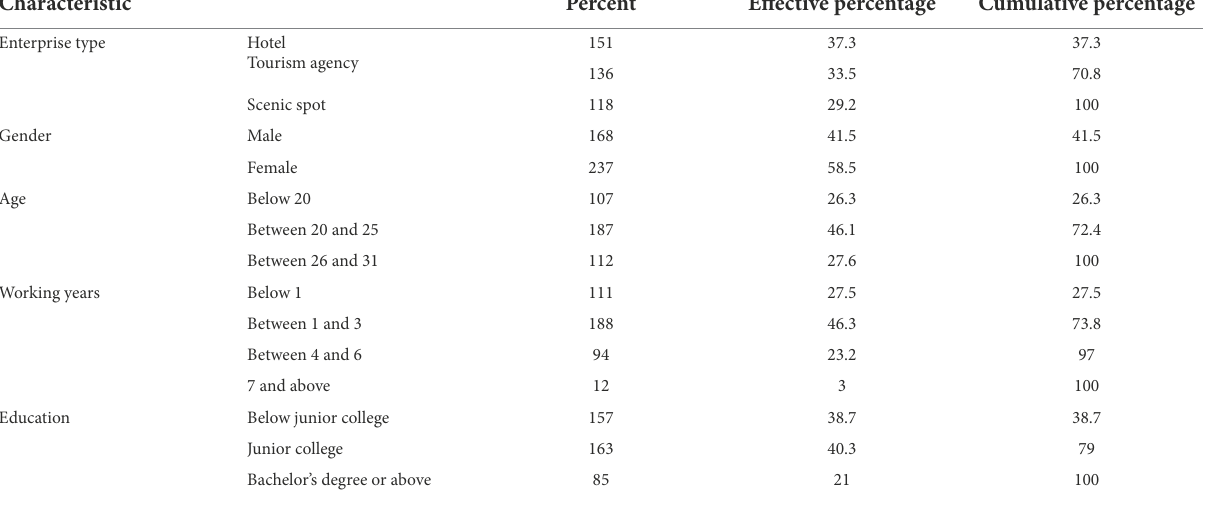
TABLE 1 Descriptive features of the sample ( N =